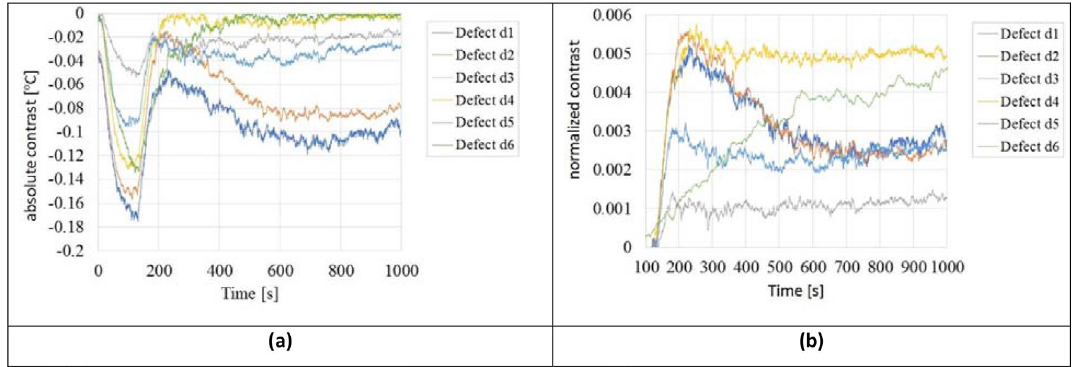
Fig. 15 Absolute contrasts ( a ) and normalized contrast ( b ) for SMArt thermography (heating time 120